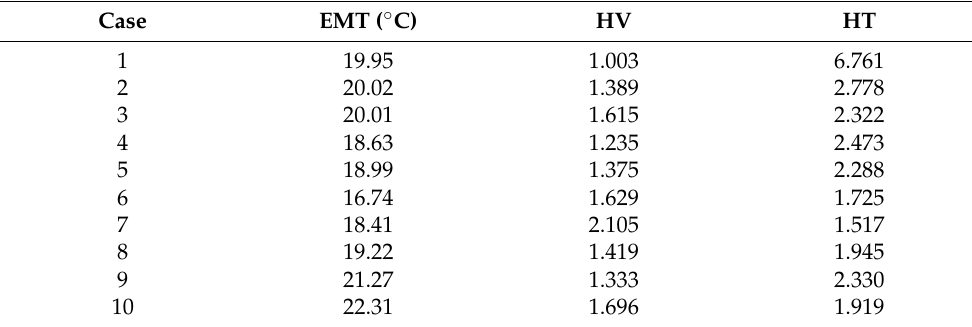
Table 4. The experimental results of HV and HT.